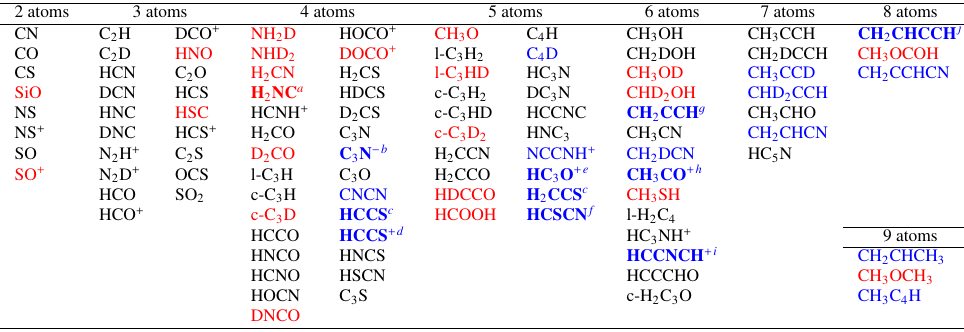
Table 1. Identified molecules within the 3mm line